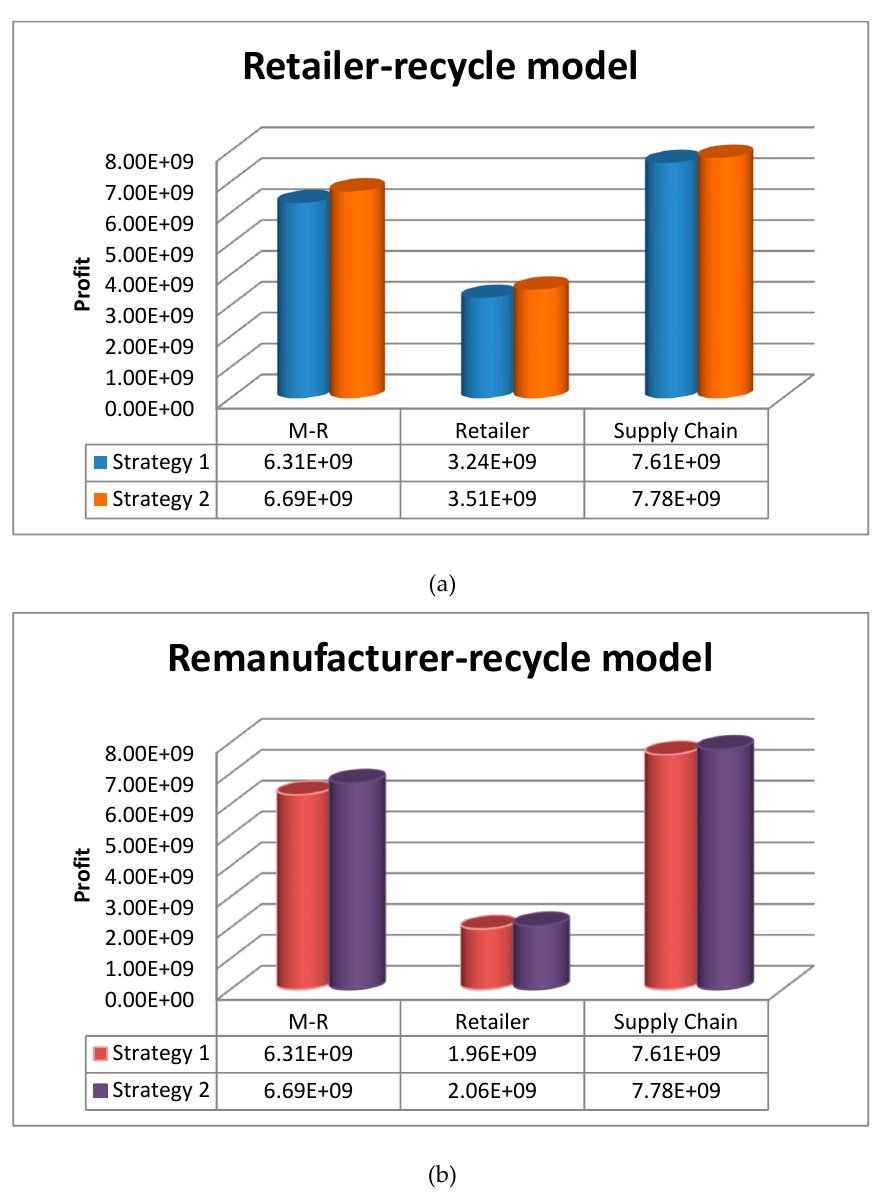
Figure 2. Strategy 1 and Strategy 2 comparison (vertical comparison). ( a ) Comparisons in the retailer-recycle model; ( b ) Comparisons in the remanufacturer-recycle model.